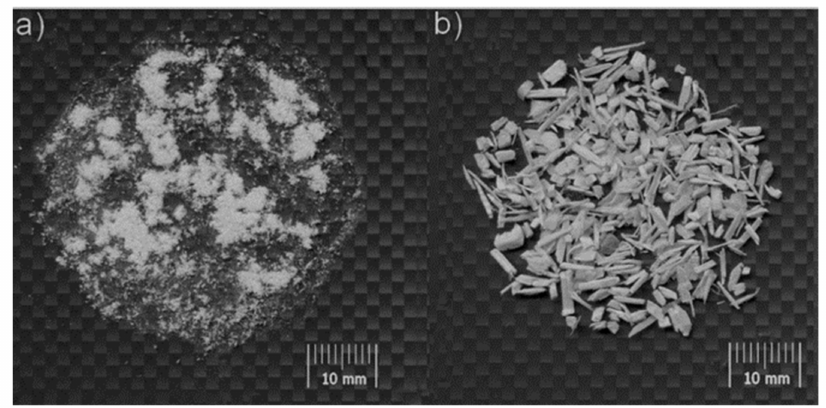
Figure 3. A real image of a coniferous wood filler: ( a ) wood flour Lignocel C120; ( b ) wood chips Lignocel